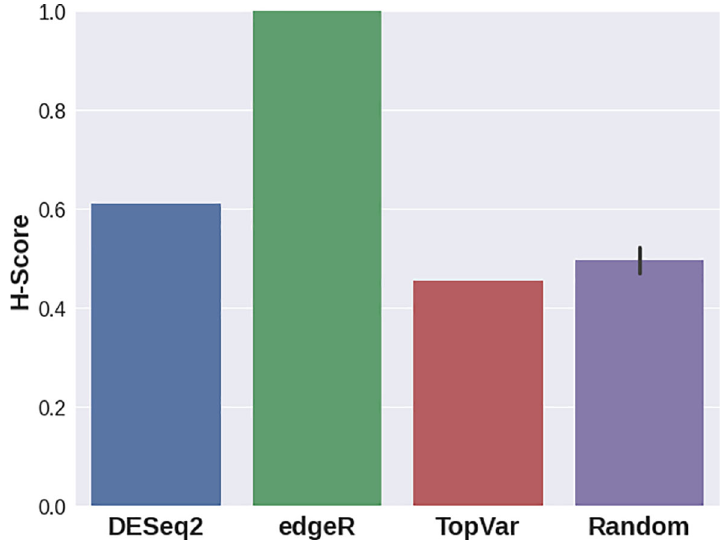
Figure 4. H-scores for the top 100 Gene Signatures delivered from DESeq2, edgeR, genes with highes variance and random gene sets applied to GSE155460 data.